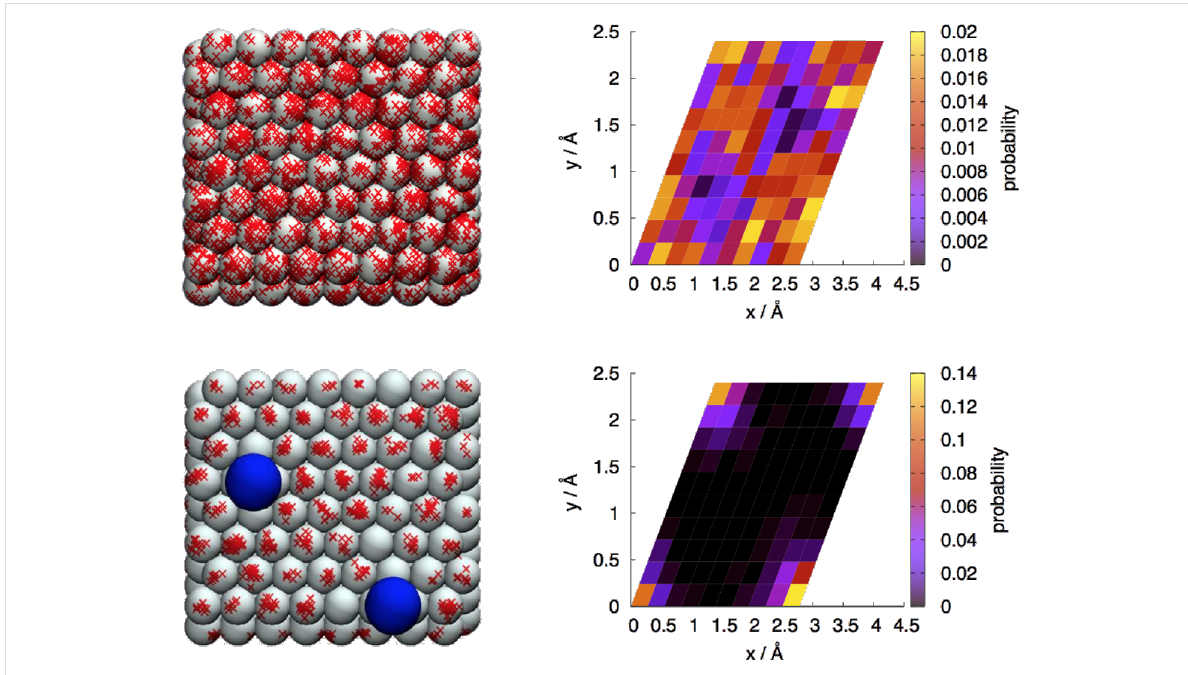
Figure 5: Lateral proton positions at the instant of discharge marked as red × symbols (left) and probability distributions of the proton positions at discharge mapped into a single surface elementary cell (right) for an interfacial layer consisting of pure water (top) and of two solvated Cl − ions (bottom).